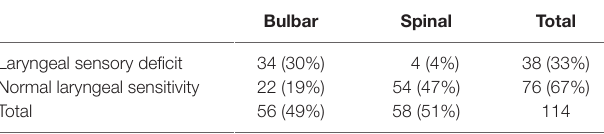
TaBle 3 | laryngeal sensitivity in relation to als onset.